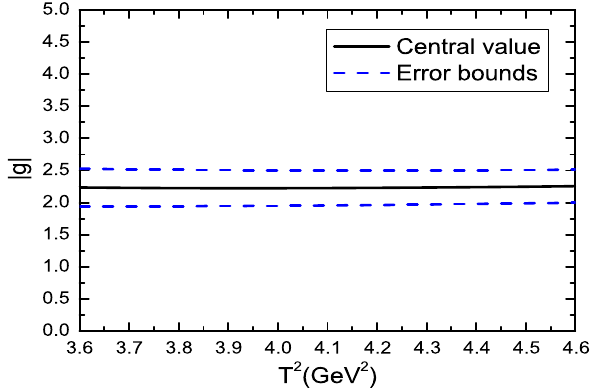
Fig. 3 The hadronic coupling constant g XJ /ψφ with variation of the Borel parameter T 2